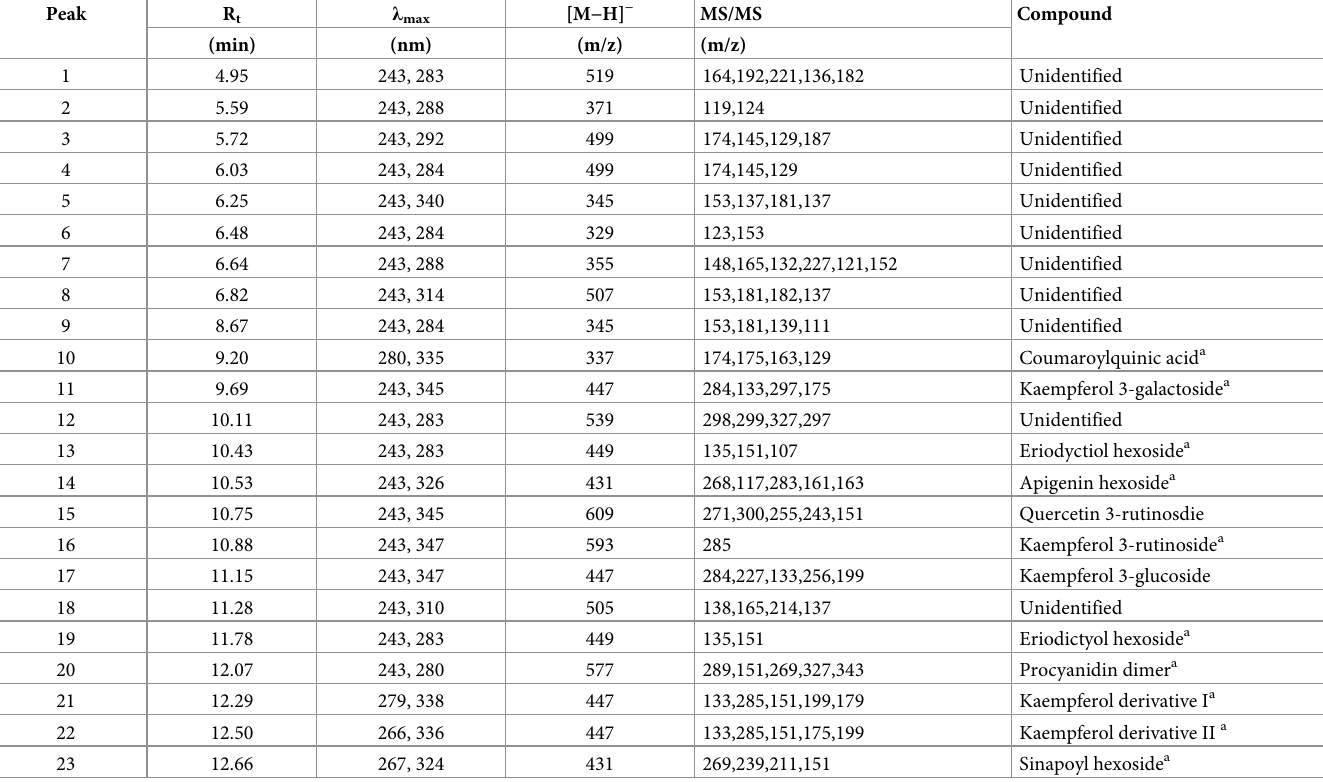
Table 2. Profile of phenolic compounds in D . pulvinatus determined by UPLC-ESI-MS/MS analysis.